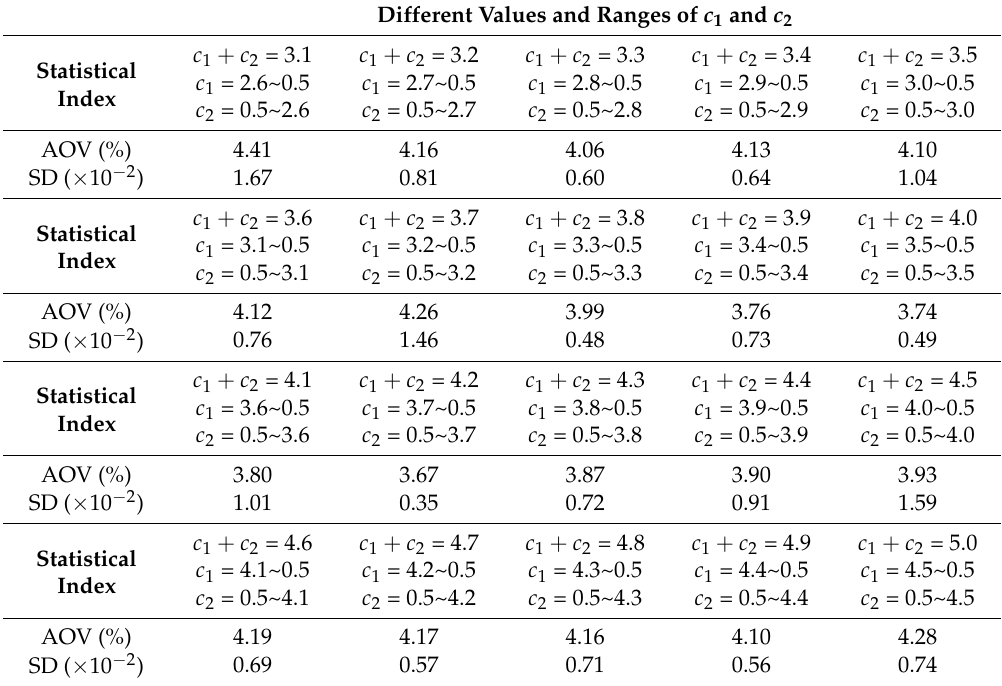
Table 5. The average optimum value (AOV) and standard deviation (SD) for 100 trials of different values of c 1 + c 2 .